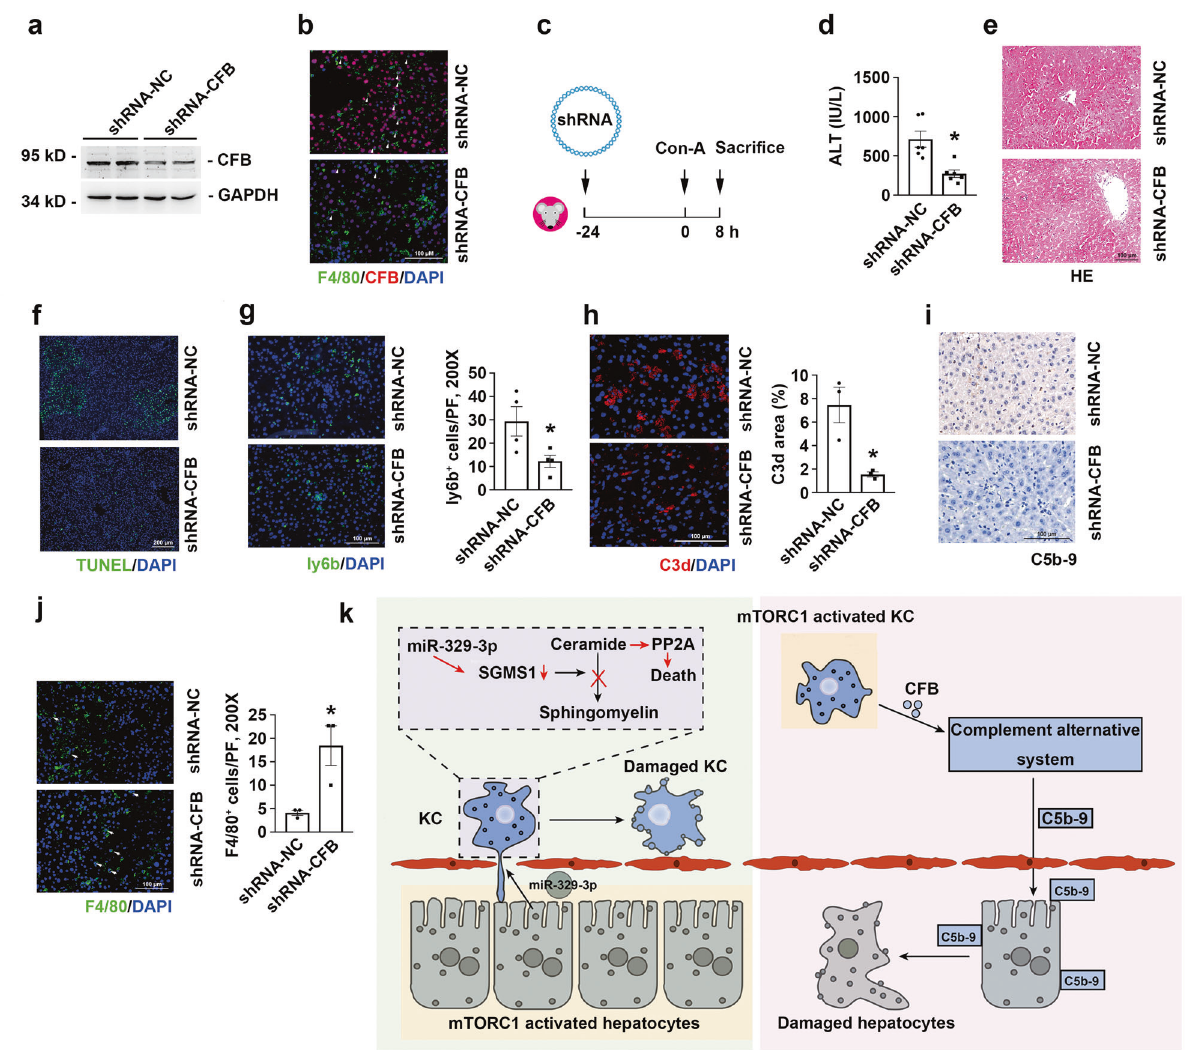
Fig. 6 Down regulation of CFB in liver protects against Con-A induced liver injury. a Western blotting assay showing CFB expression in mouse livers after shRNA-CFB injection. b Representative co-immuno fl uorescent staining images for F4/80 with CFB (white arrows). Scale bar = 100 μ m. c The strategy for establishing a mouse model of injection of shRNA-CFB and Con-A administration. d The ALT levels in serum of mice exposed to Con-A for 8 h, n = 6. e Representative HE-stained mouse livers. Scale bar = 100 μ m. f Liver sections of were immuno fl uorescent stained with TUNEL. Scale bar = 200 μ m. g Left, representative immuno fl uorescent staining images for ly6b. Scale bar = 100 μ m. Right, quantitative determination of ly6b + cells among groups as indicated, n = 4. h Left, representative immuno fl uorescent staining images for C3d. Scale bar = 100 μ m. Right, quantitative determination of C3d area in a fi eld of vision, n = 4. i Representative immunostaining images for C5b-9. Scale bar = 100 μ m. j Left, representative immuno fl uorescent staining images for F4/80 (white arrows). Scale bar = 100 μ m. Right, quantitative determination of F4/80 + cells among groups as indicated, n = 4. * p < 0.05. k Schematic working model on the role of mTORC1 activation in hepatocytes and KCs in the pathogenesis of